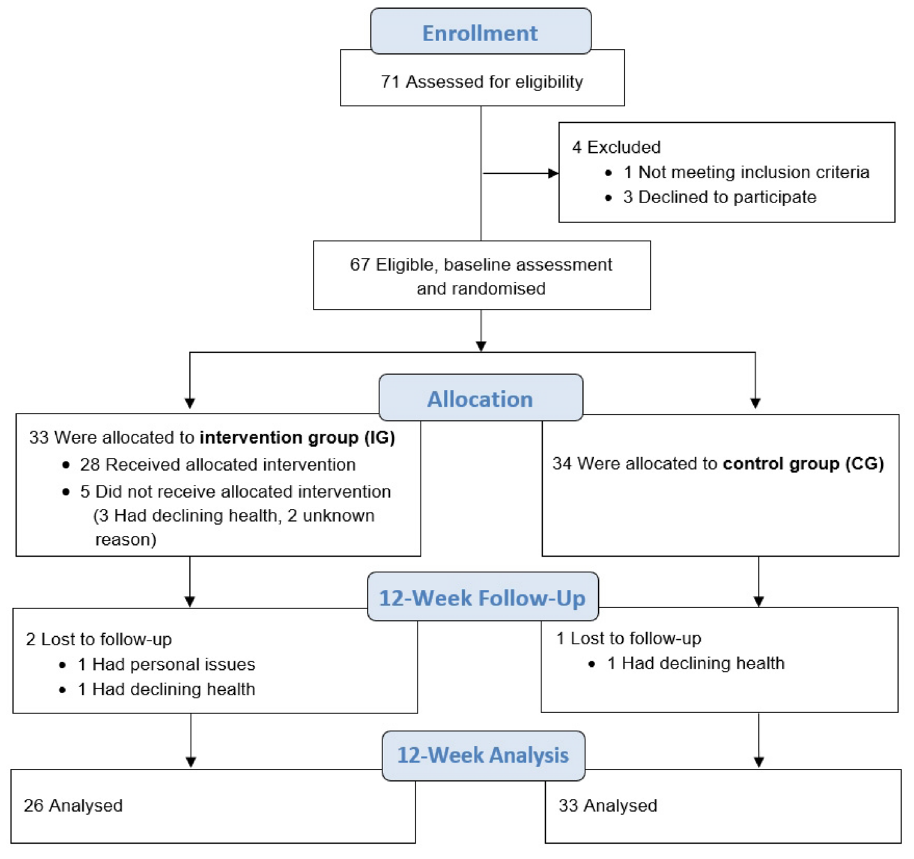
Figure 2. Flowchart for enrolment, randomization, and follow-up of study